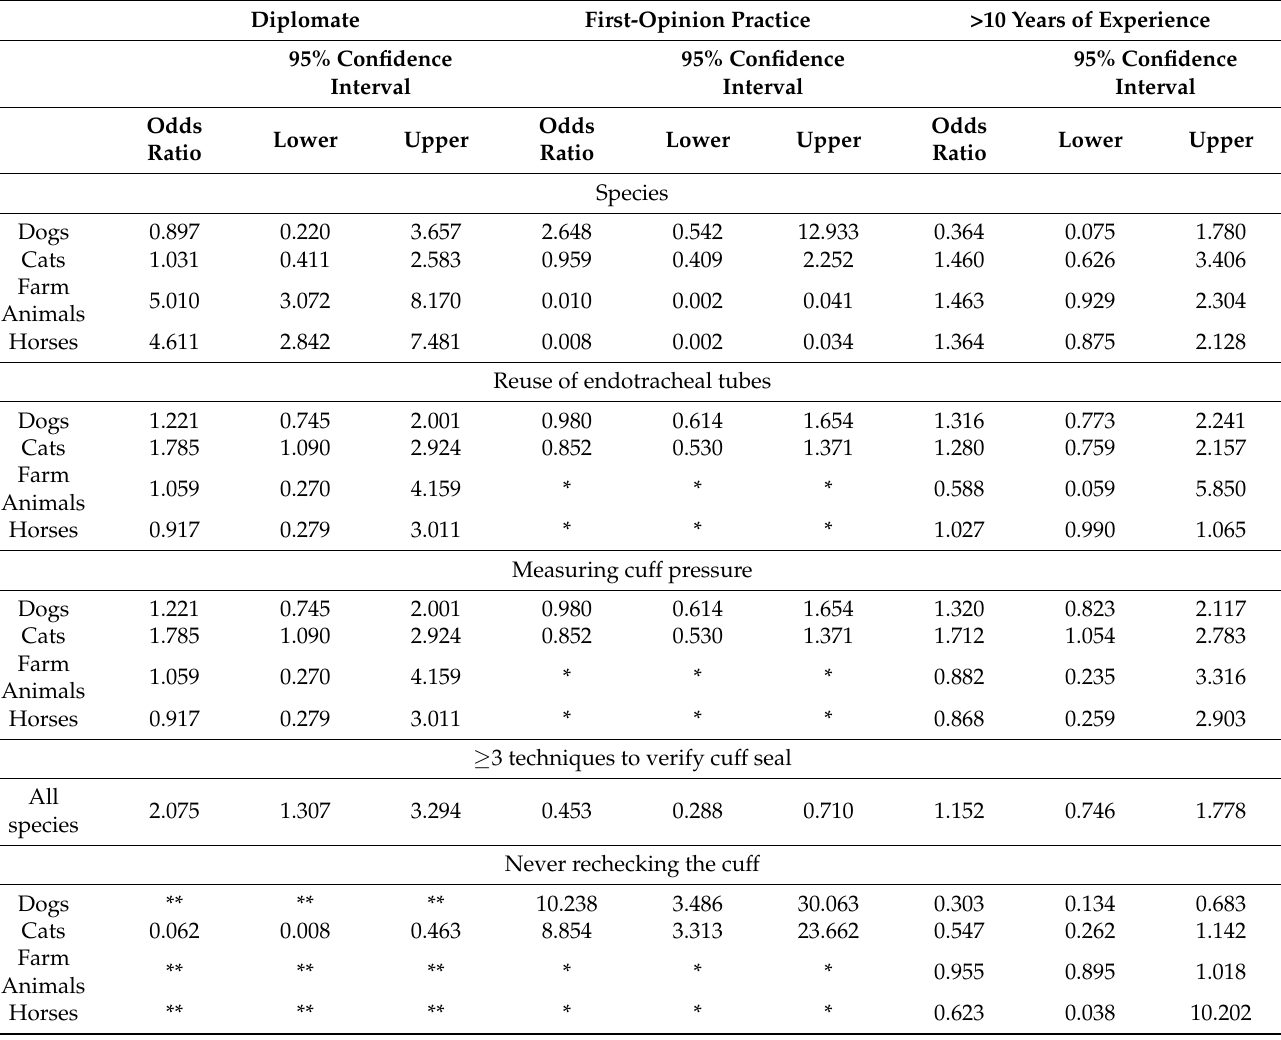
Table 2. Odds ratio for frequency of responses for diplomates, first-opinion practitioners and respon- dents more than 10 years of experience for selected questionnaire